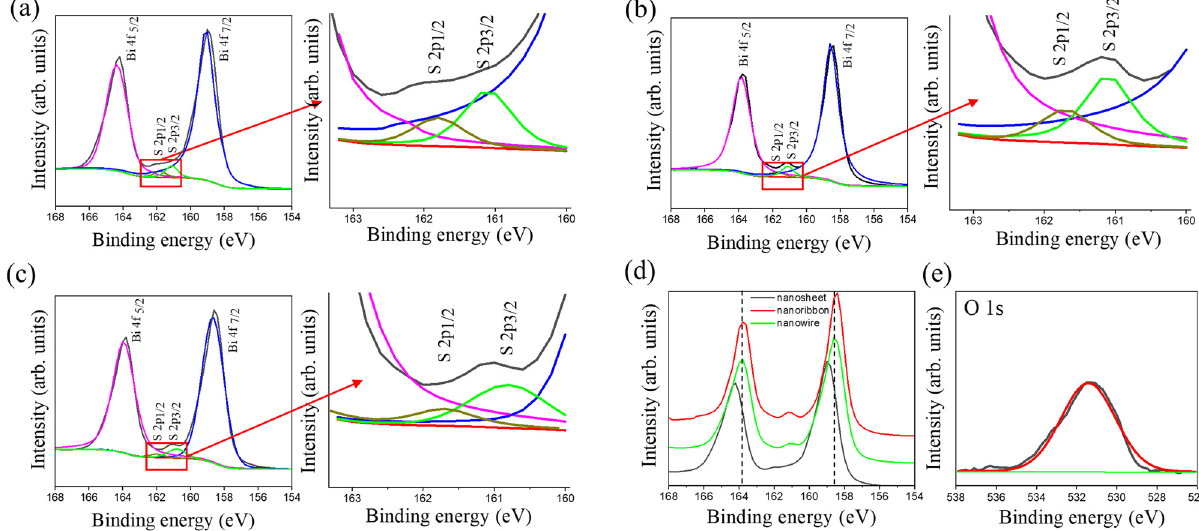
Figure 4: Narrow scan XPS spectra of the Bi 4f and S 2p regions taken from di ff erent Bi 2 S 3 products: ( a ) nanosheet, ( b ) nanoribbon, and ( c ) nanowire. ( d ) Comparison of Bi 4f core - level binding energy of all products. ( e ) The representative O 1s spectrum of Bi 2 S 3 nanosheets. The red line is the fi tted